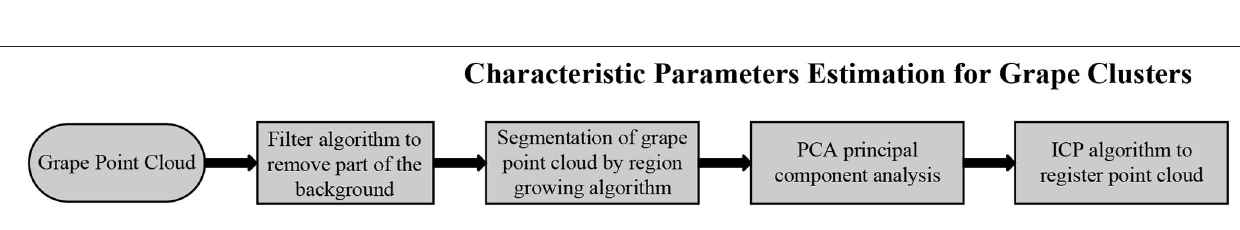
FIGURE 3 | Grape point cloud data preprocessing